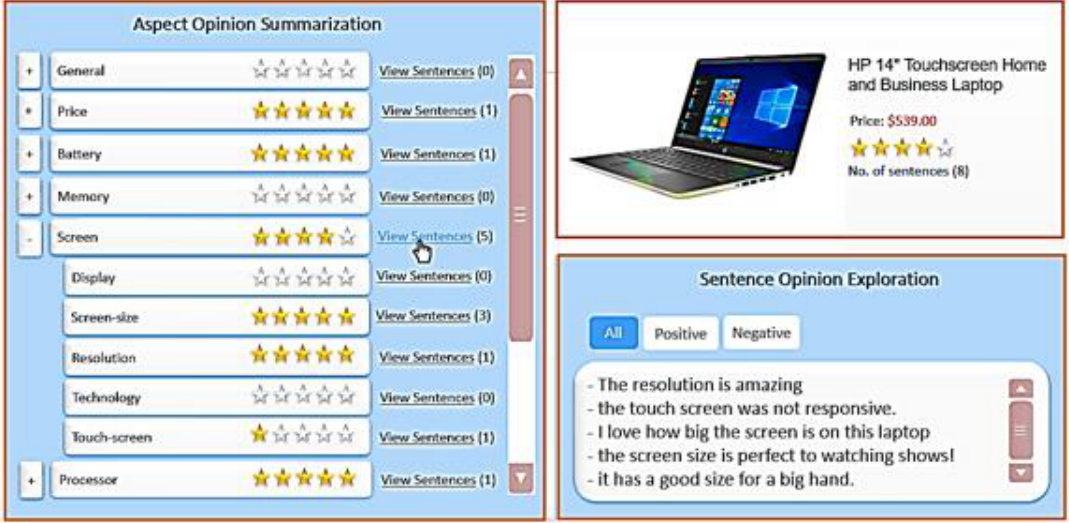
Figure 9. Screenshot of our SEOpinion system.